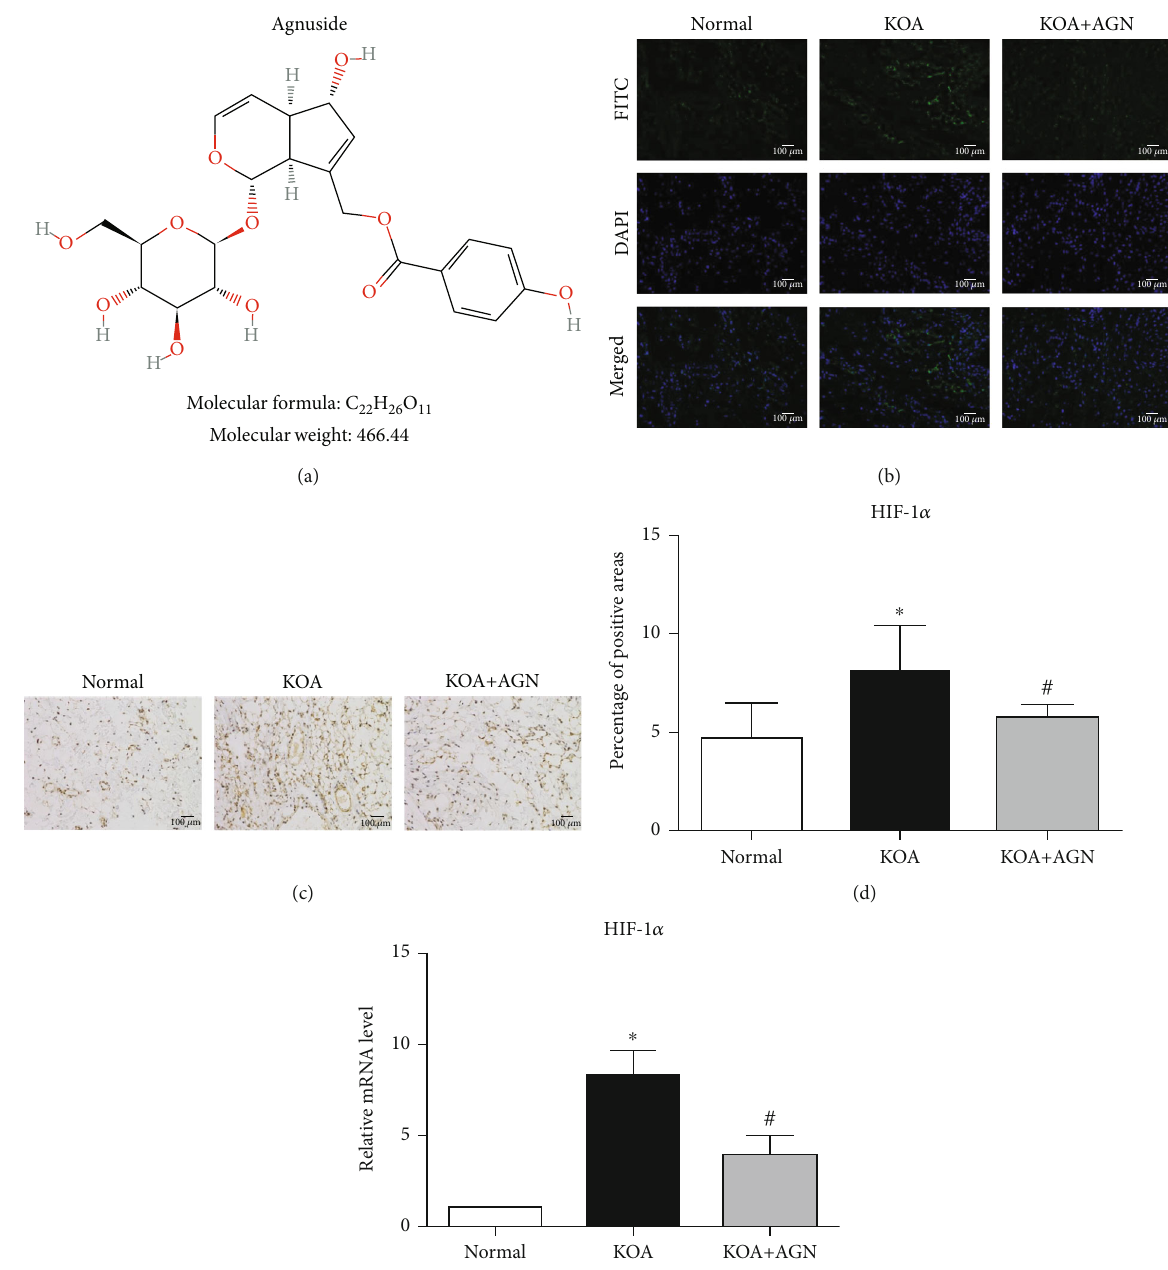
Figure 1: Agnuside relieves the state of hypoxia in KOA rats. (a) The chemical structure of AGN. (b) Representative synovial tissues stained with pimonidazole, 200x, scale bar = 100 μ m. (c) Representative HIF-1 α immunohistochemical sections of synovial tissues in each group, 200x, scalebar = 100 μ m. (d) The percentage of HIF-1 α -positive areas in each group. Data were analyzed by ImageJ. ∗ P < 0 : 05 , compared with the normal group. # P < 0 : 05 , compared with the KOA group. (e) mRNA level of HIF-1 α between groups. ∗ P < 0 : 05 compared with the normal group. # P < 0 : 05 , compared with the KOA